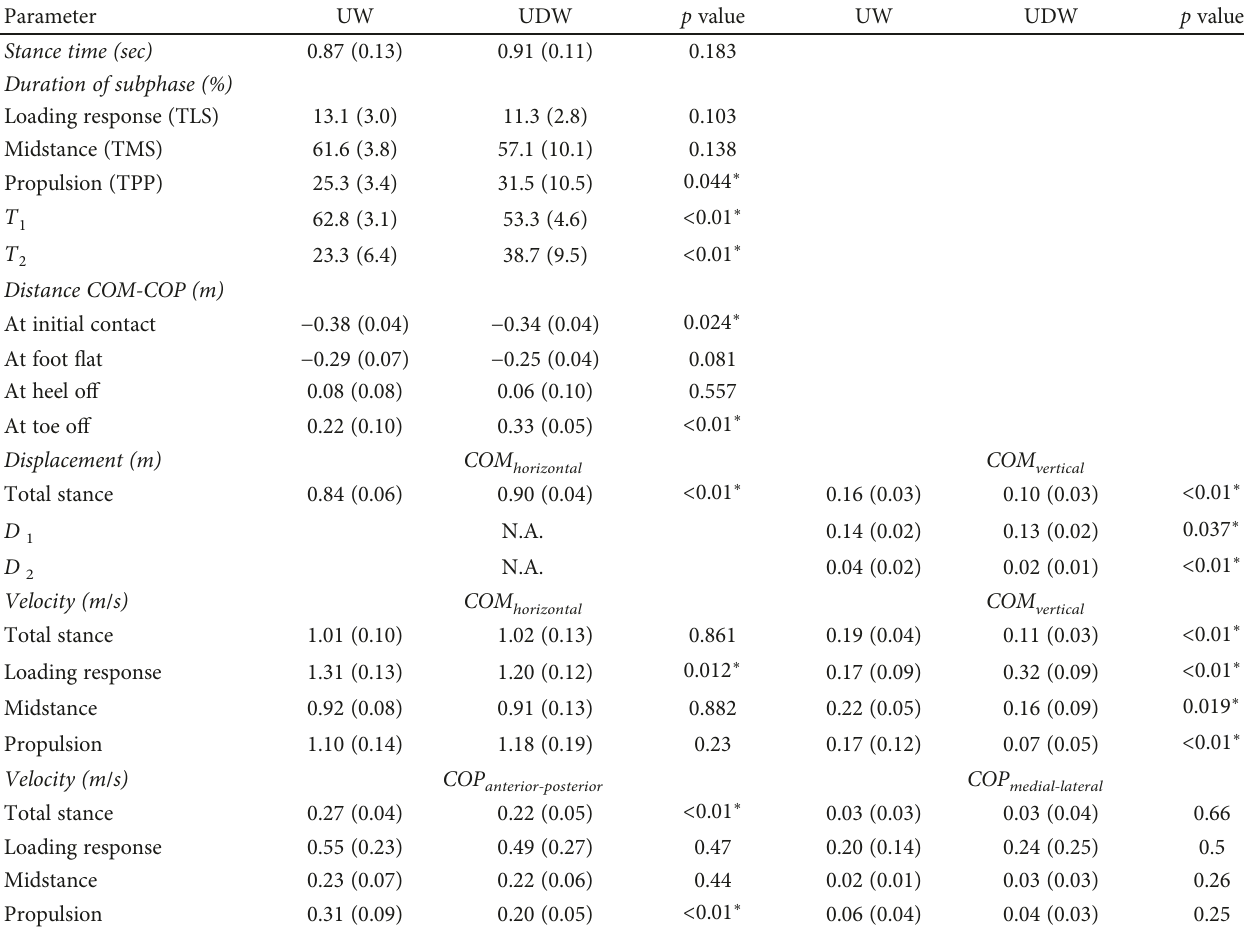
Table 1: Mean (standard deviation) of duration, COM and COP movement parameters during UW and